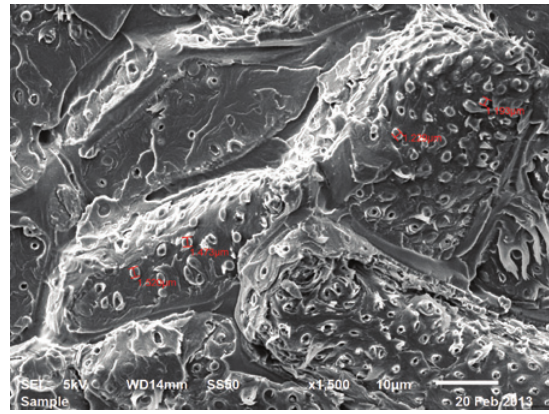
Figure 1 SEM micrograph for (CY-230+8 wt% HY-951+0.5 wt% TCP+50 wt% AP) at magnification × 1500.